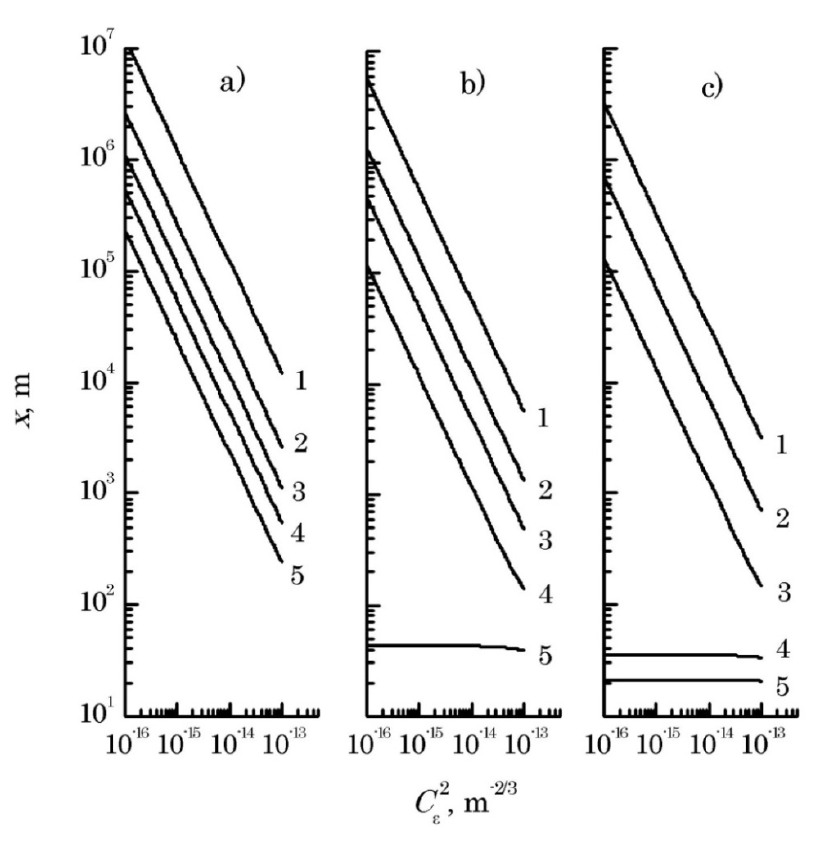
Figure 3. Laser beam range as a function of the structural parameter of atmospheric turbulence at radiation wavelength λ = 1.06 μ m and interference pattern visibility v( х ) = 0.1 ( a ), 0.3 ( b ) and 0.5 ( c ) for different distances between the beam centers ρ tr = 0.01 (1), 0.02 (2), 0.03 (3), 0.04 (4), and 0.05 m